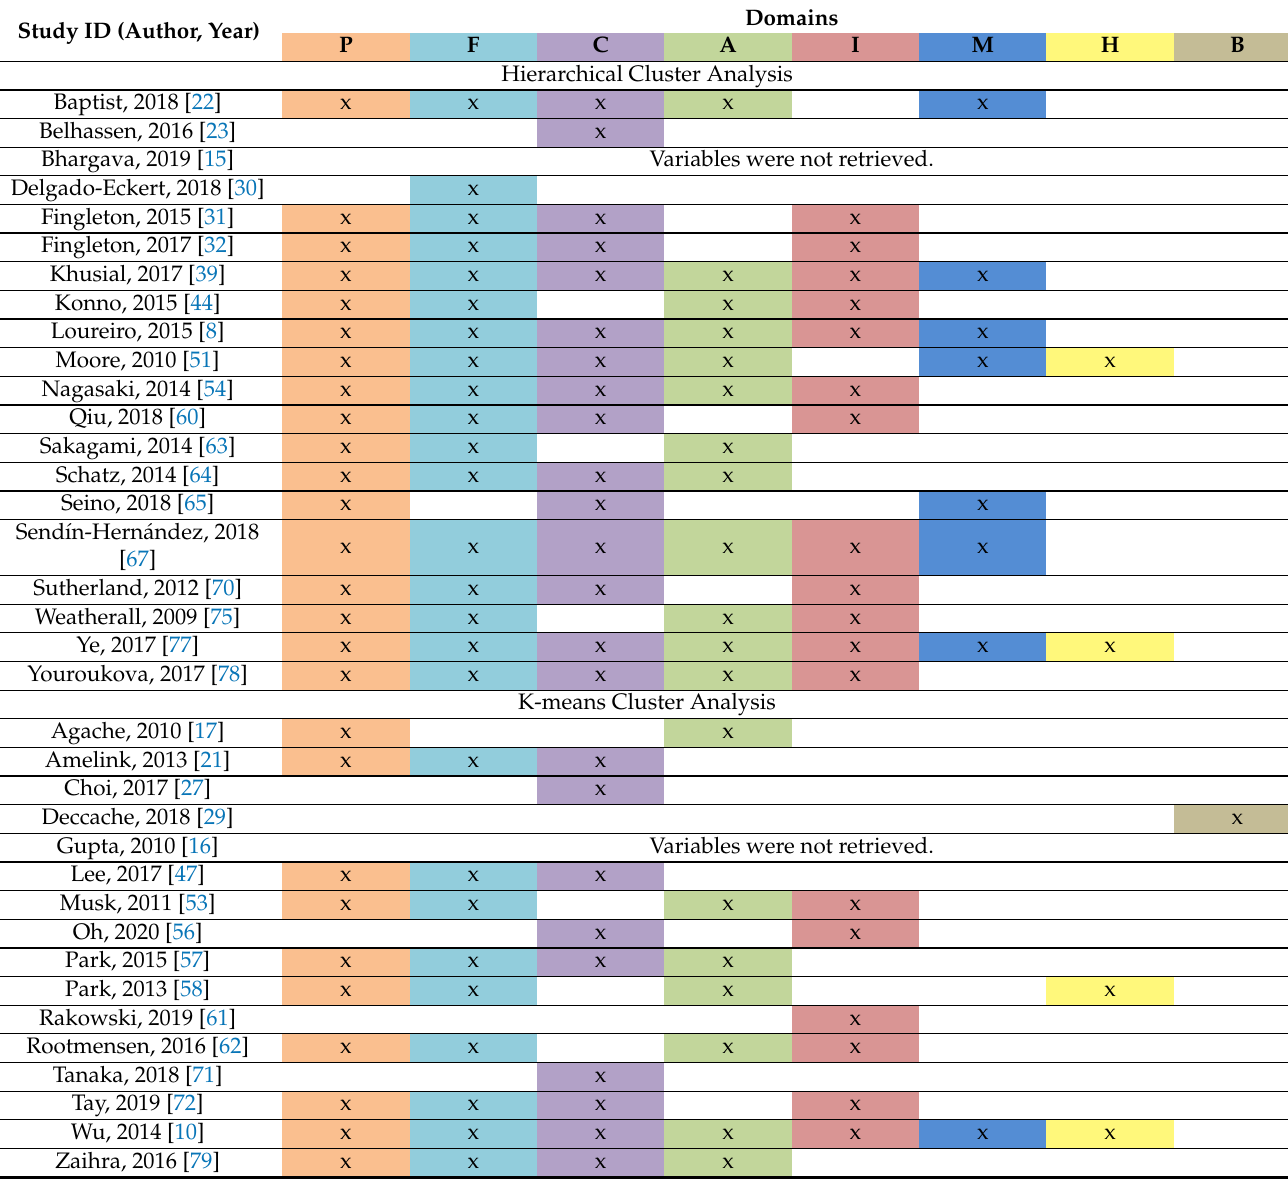
Table A1. Representation of variables used by each study, stratified by a data-driven method. Studies with an evaluation of phenotype consistency are marked. Variables are presented in the form of domains: personal (P), functional (F), clinical (C), atopy (A), inflammatory (I), medication (M), health care use (H), and behavioral